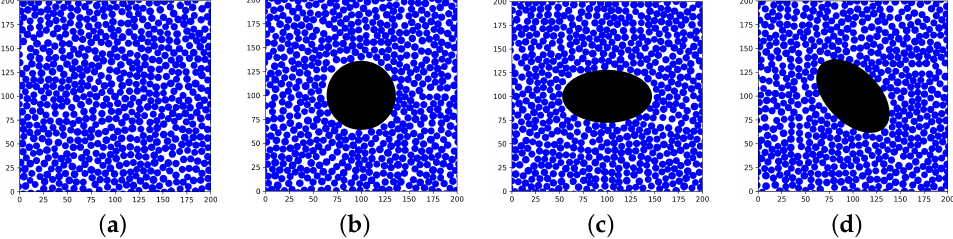
Figure 4. Periodic RVEs generated with the algorithm ( a ) without a void, ( b ) with a circular void, ( c ) with an elliptical void angled 0 ◦ , and ( d ) with an elliptical void angled 45 ◦